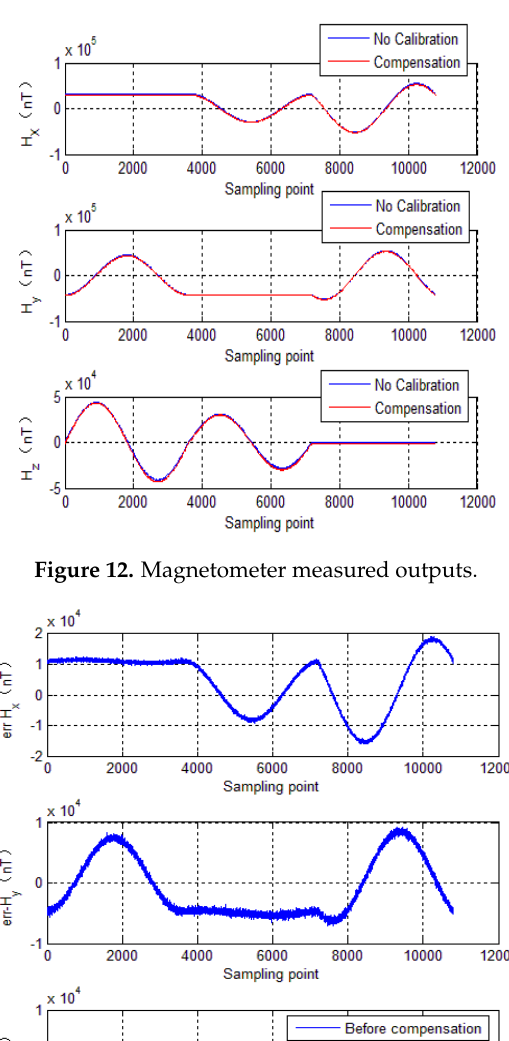
Figure 12. Magnetometer measured outputs.